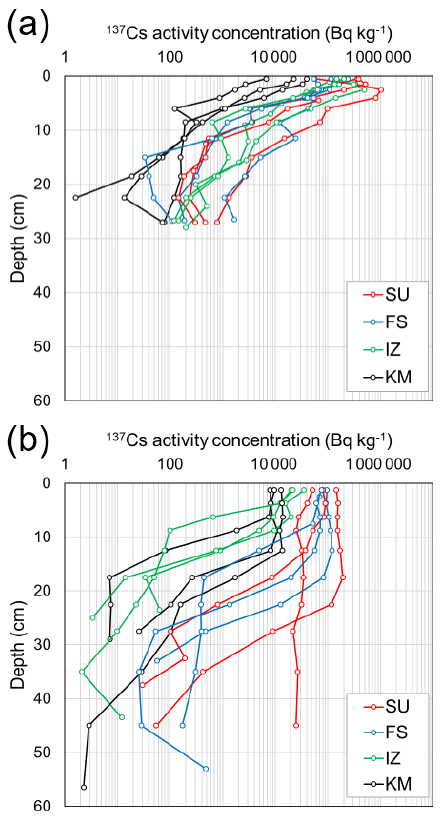
Figure 4. Vertical distribution of 137 Cs activity concentration in soil (a) and bottom sediment (b) .